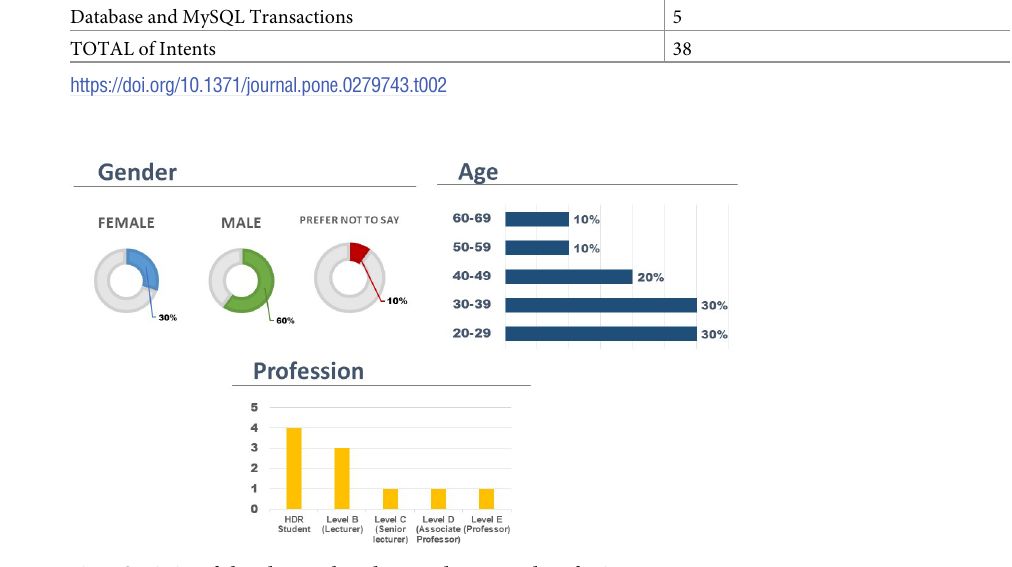
Fig 5. Statistics of closed group based on gender, age and profession.